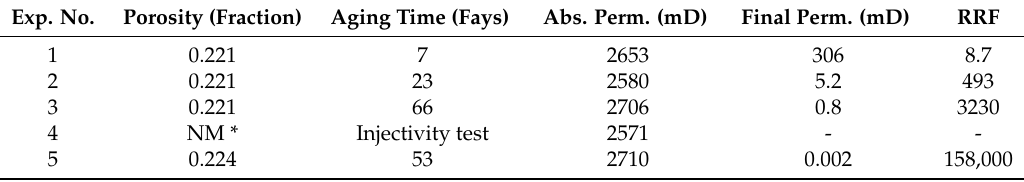
Table 5. Porosities, initial and final permeabilities, and residual resistance factors for various aging times.